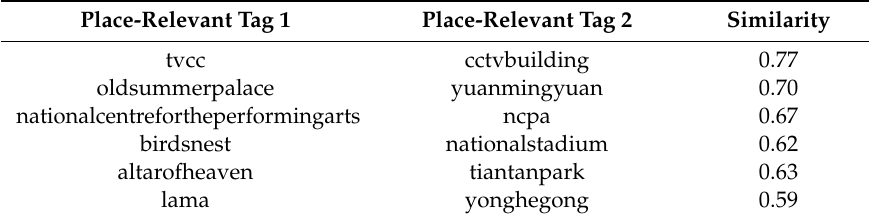
Table 3. Some results of high similarity among place-relevant